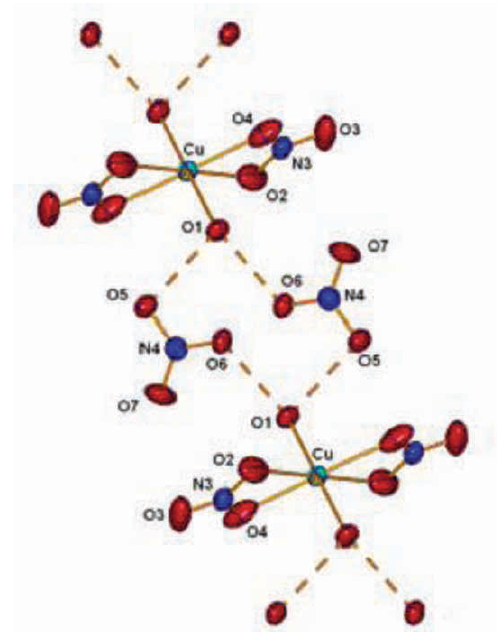
Figure 2. Infinite anionic one-dimensional hydrogen-bond assem-